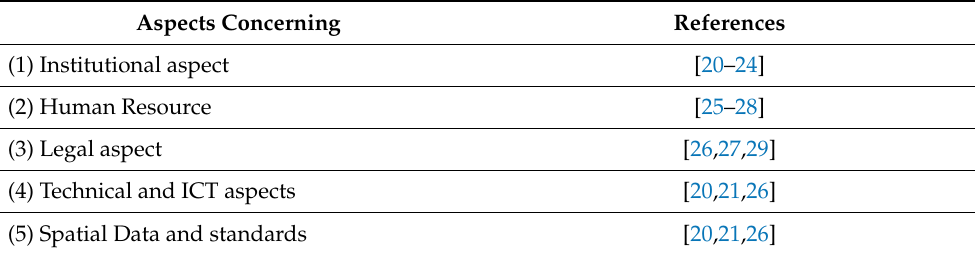
Table 1. Aspects concerning spatial data sharing practice in